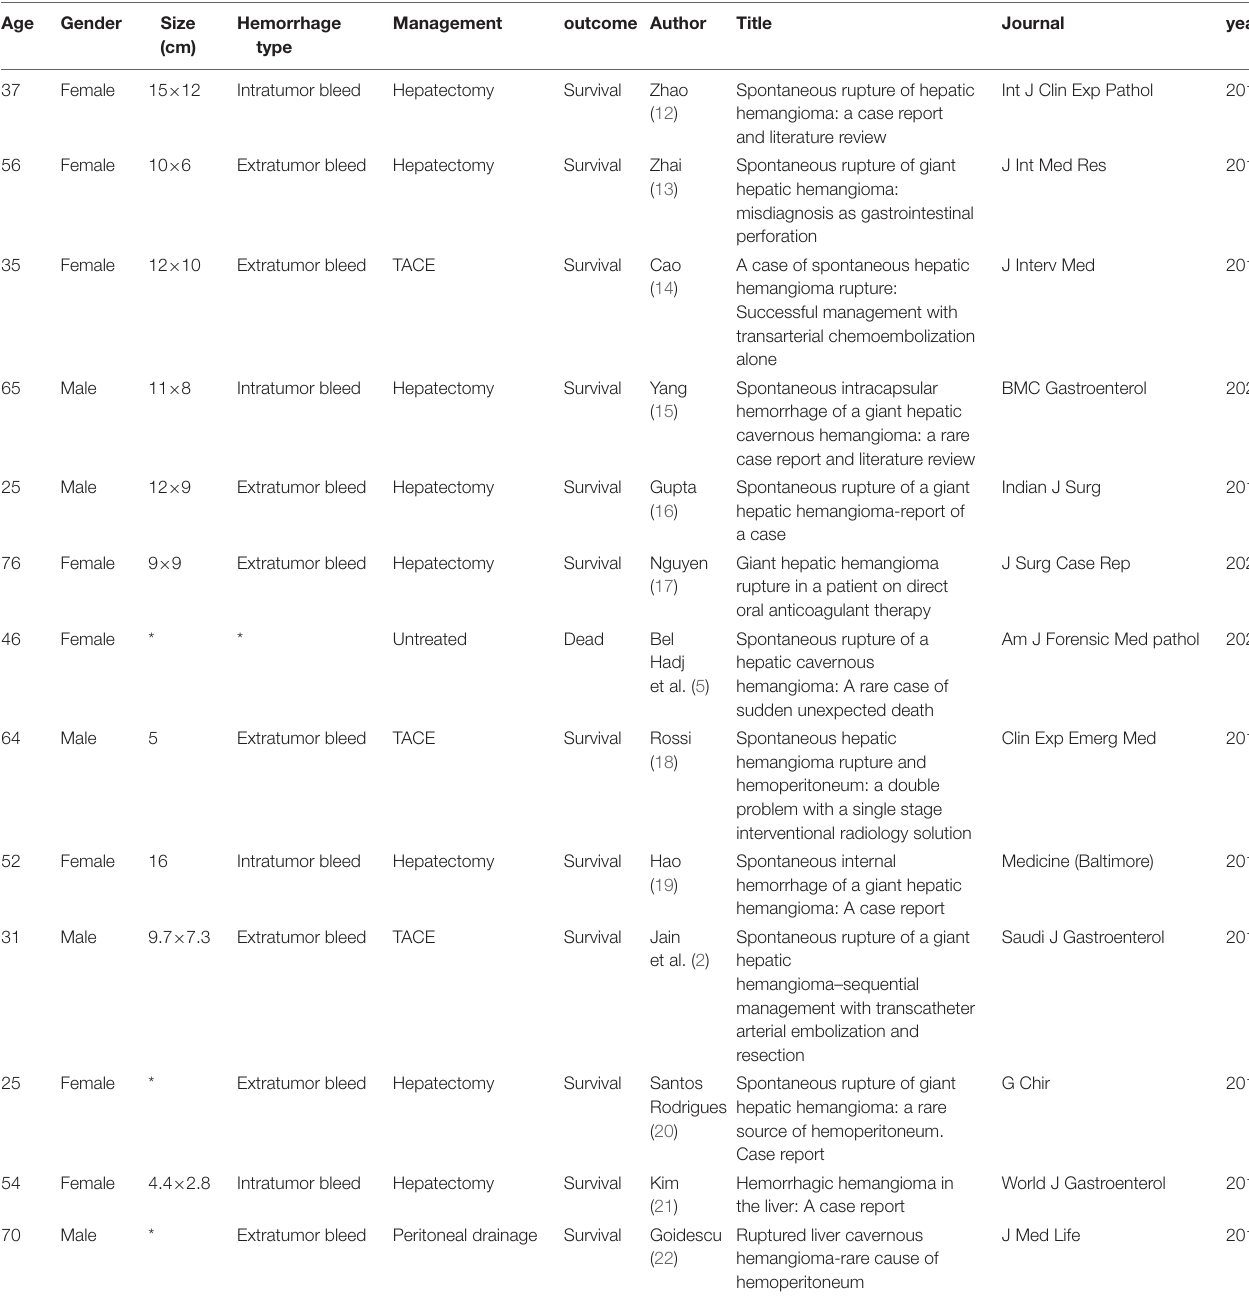
*Represent that there is no detailed description in the original